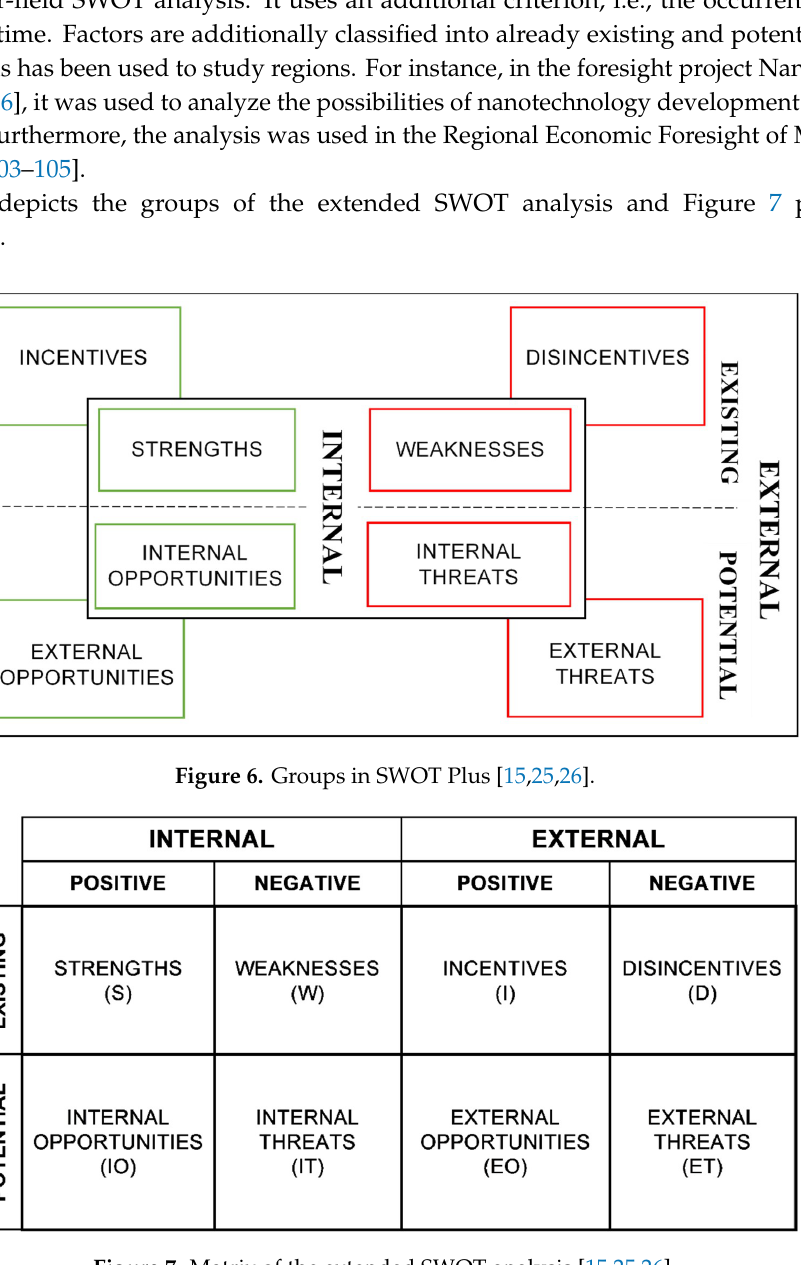
Figure 7. Matrix of the extended SWOT analysis [15,25,26].